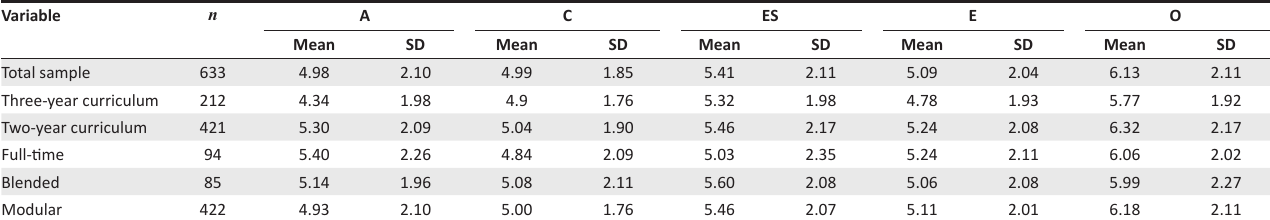
TABLE 1: Five-factor model trait scores of participants ( n = 633). Variable